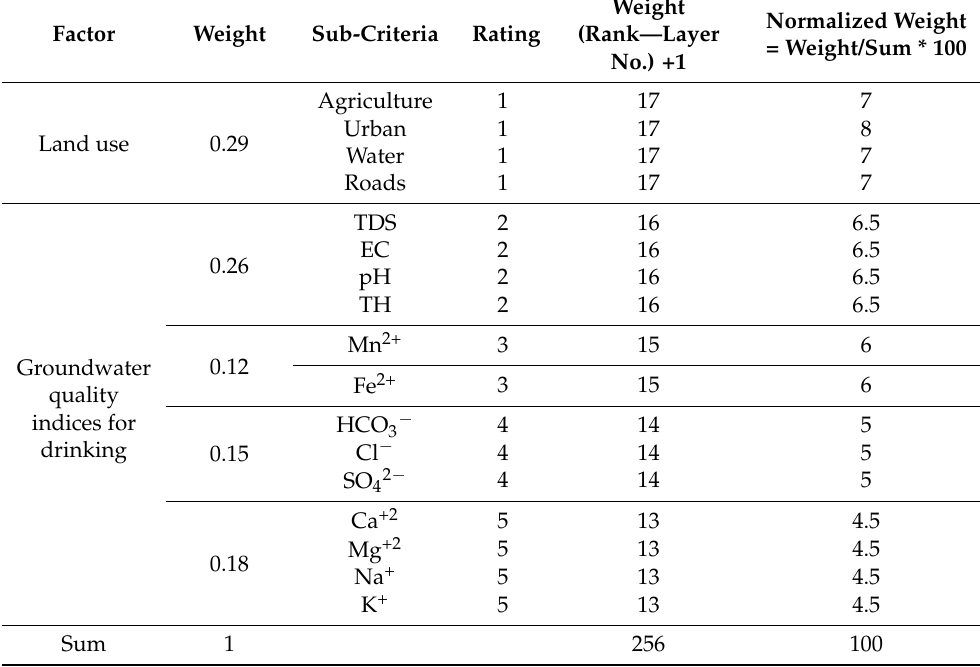
Figure 7. Flow chart of a water quality spatial model for drinking purposes. Table 4. The rating scores and relative weights of the factors and sub-criteria used for the drinking assessment.